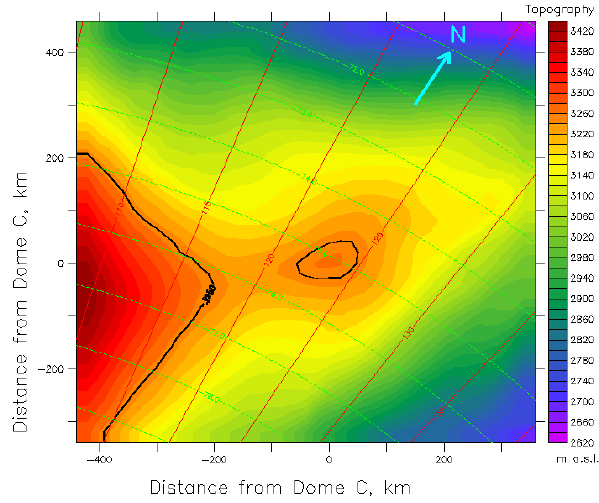
Figure 1. MAR integration domain and topography (colour). Solid line represents the 3250m